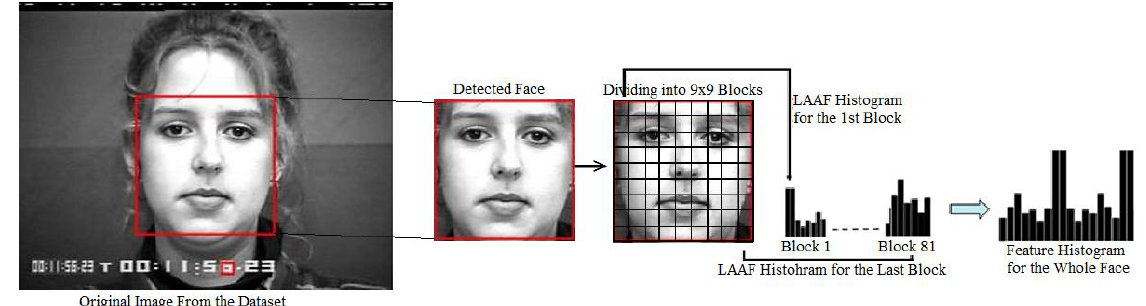
Figure 8. Steps of Facial Feature Extraction